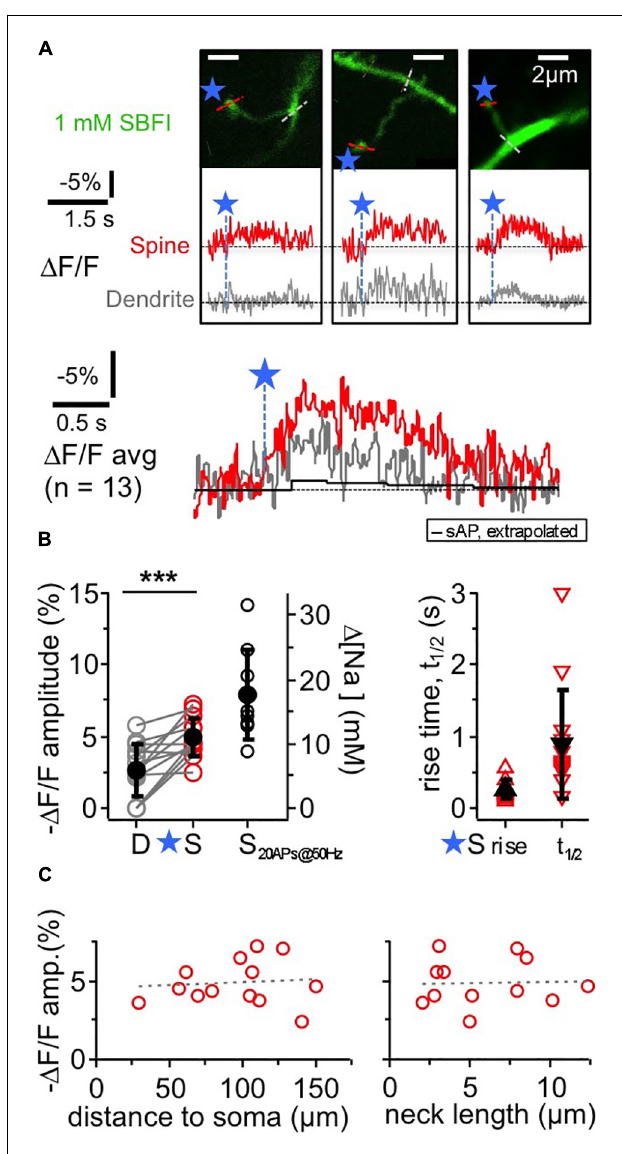
FIGURE 2 | TPU-evoked Na + entry into juvenile rat GC spines. Imaging of TPU-evoked Na + transients within GC spines with low exogenous buffering (1 mM SBFI). Experimental setup as in Figure 1A . (A) See also Figure 1B . Top: two-photon z-stacks of three representative examples of individual spines filled with SBFI. Blue stars denote uncaging locations. Red and gray dotted line indicate line scan positions for the leftmost spine. Middle: respective averaged fluorescence transients ( (cid:49) F/F) TPU within the above spines (S, red) and within the adjacent dendrite (at the base of the spine neck, D, gray). Bottom: ( (cid:49) F/F) TPU transients averaged across experiments ( n = 13 spines) with the same time axis, spine response in red and dendrite response in gray. Note the similar time course of the dendritic response. Black trace: extrapolated response ( (cid:49) F/F) AP to a single backpropragating somatically evoked AP (from mean response to 20 APs at 50 Hz, see (B) Amplitude ( (cid:49) F/F) AP ≈ –0.4%, t 1 / 2 ≈ 1.7 s). (B) Cumulative plots. Left panel: ( (cid:49) F/F) TPU amplitudes in dendrite and spine pairs (highly significantly different, P < 0.001, Wilcoxon test) and ( (cid:49) F/F) 50 H z amplitudes in response to a 50 Hz train of 20 APs in a subset of the same spine heads ( n = 9). Right axis: changes in [Na + ] i concentration (calibration from Ona-Jodar et al., 2017). Right panel: